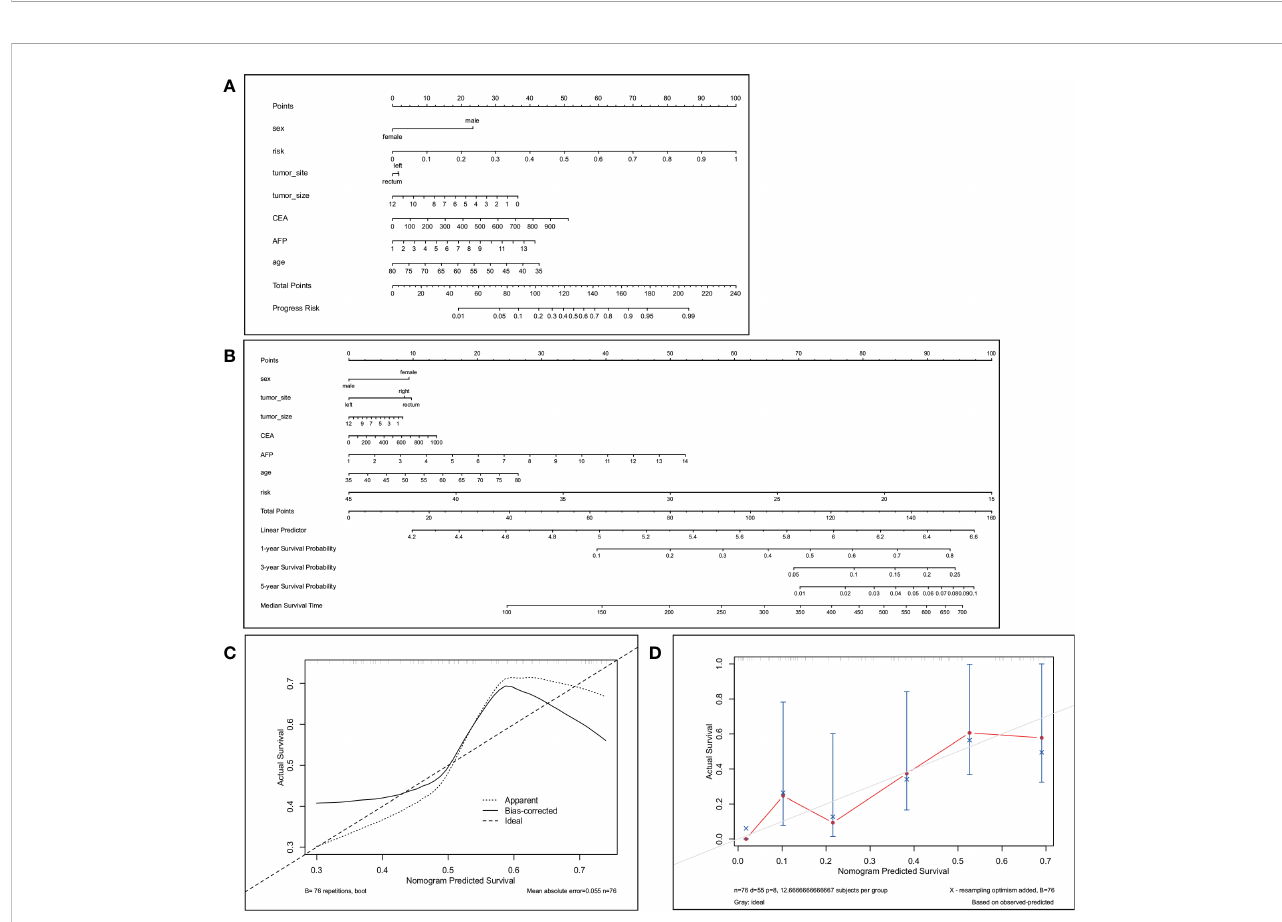
FIGURE 4 The nomogram (A) predicts the best response in patients with CRLM. The total score is calculated by summing the points for each factor. The total score corresponds to the patient ’ s best response prediction. (C) is the calibration curve corresponding to the nomogram. The nomogram (B) predicts 1-year, 3-year and 5-year PFS in patients with CRLM. Total points are calculated by summing the points for each factor. The total score corresponds to the 1-, 3-, and 5-year PFS probabilities of the patients. (D) Calibration plots to predict 1-year progression-free survival